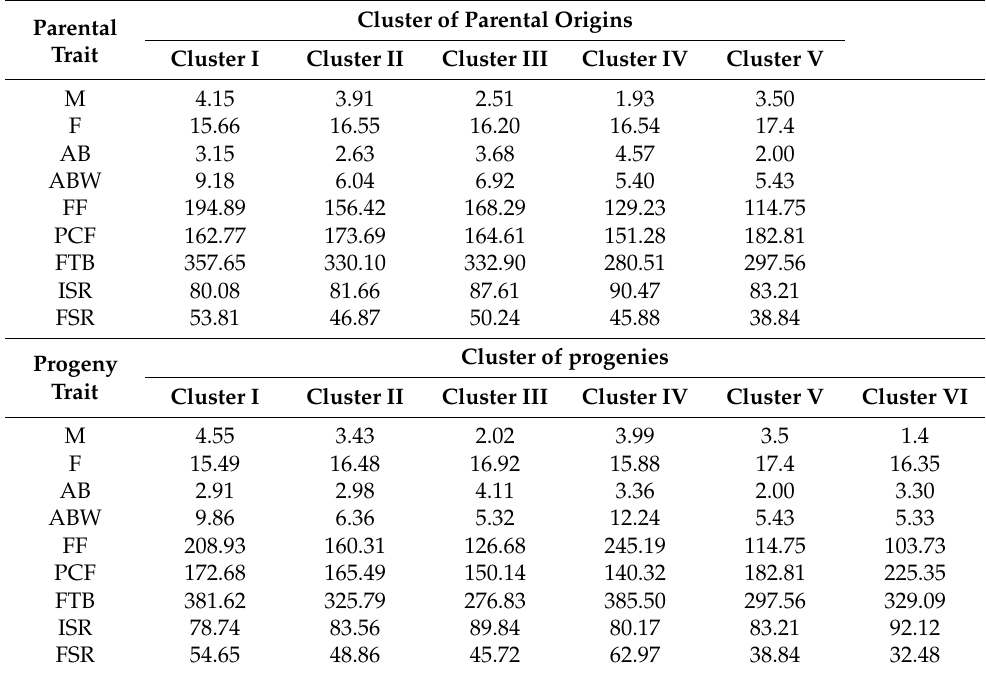
Table 6. Means of cluster assembly and their quantitative characters for parents and their progenies.